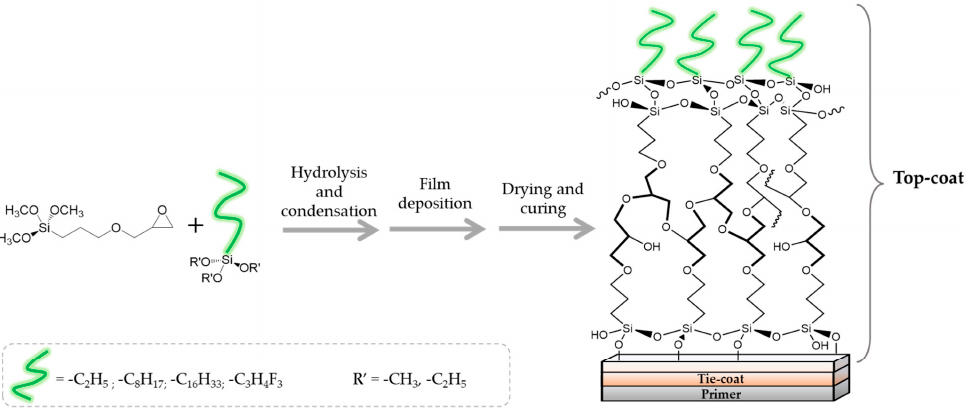
Figure 19. Synthetic steps involving the production of the eco-friendly sol–gel hydrophobic anti- fouling coating. Reproduced from MDPI Ref. [71].